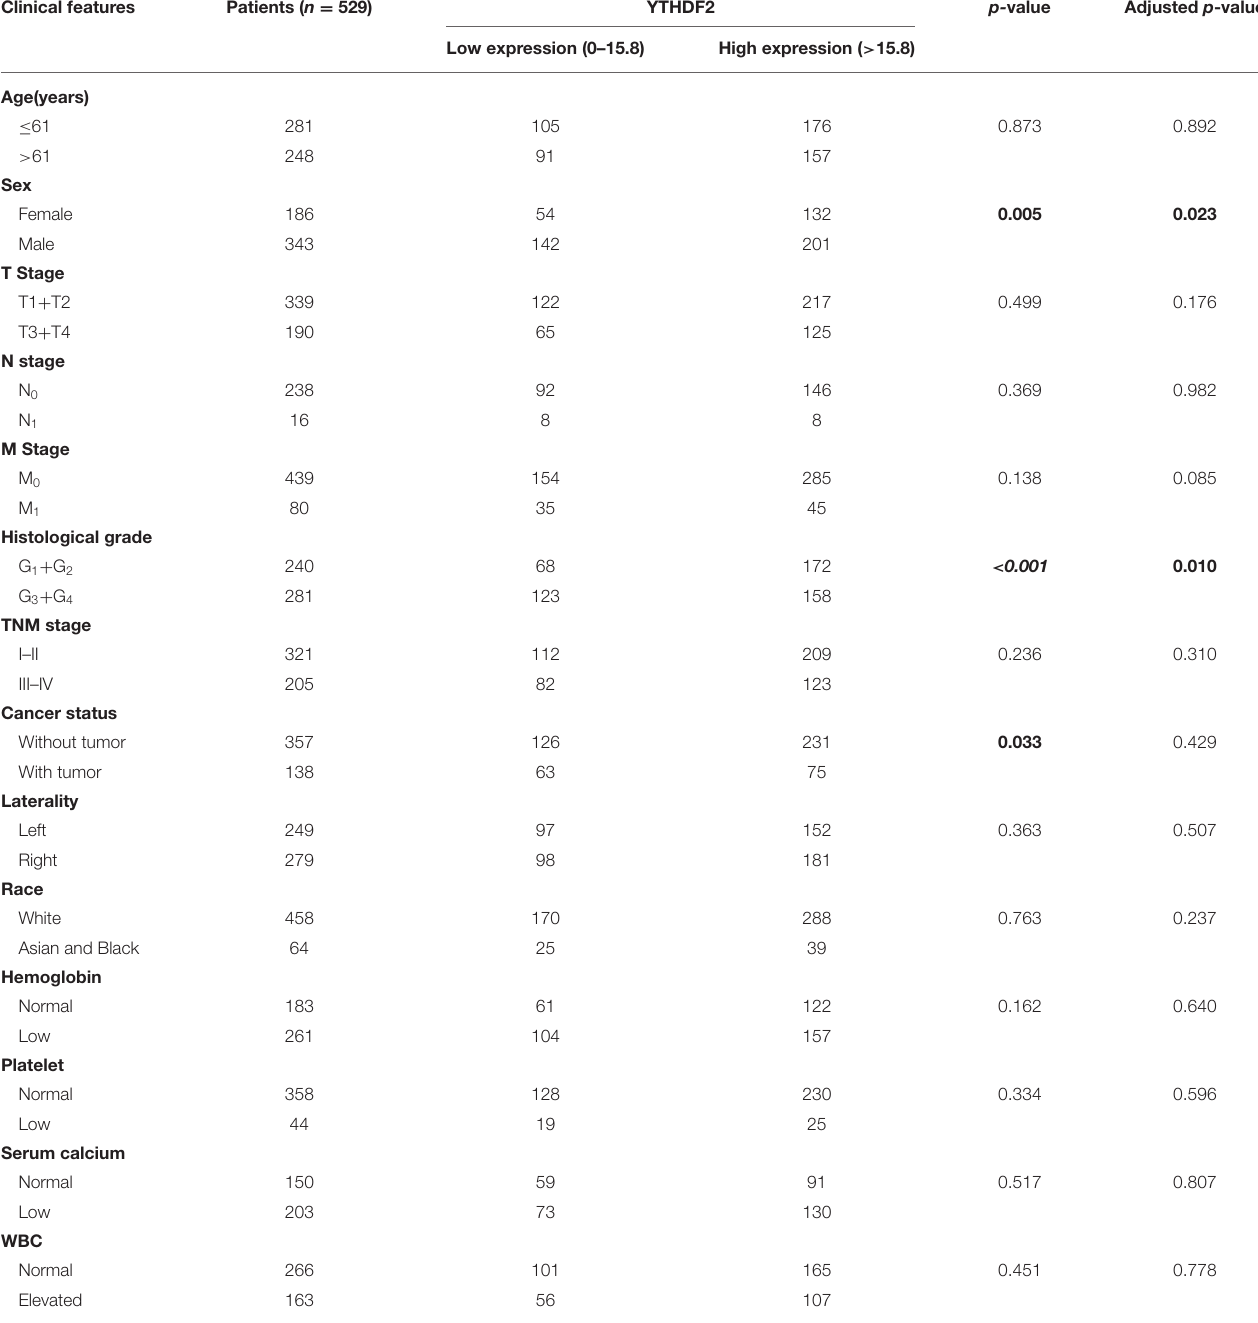
TABLE 3 | Correlation of YTHDF2 expression and clinicopathological variables. Clinical